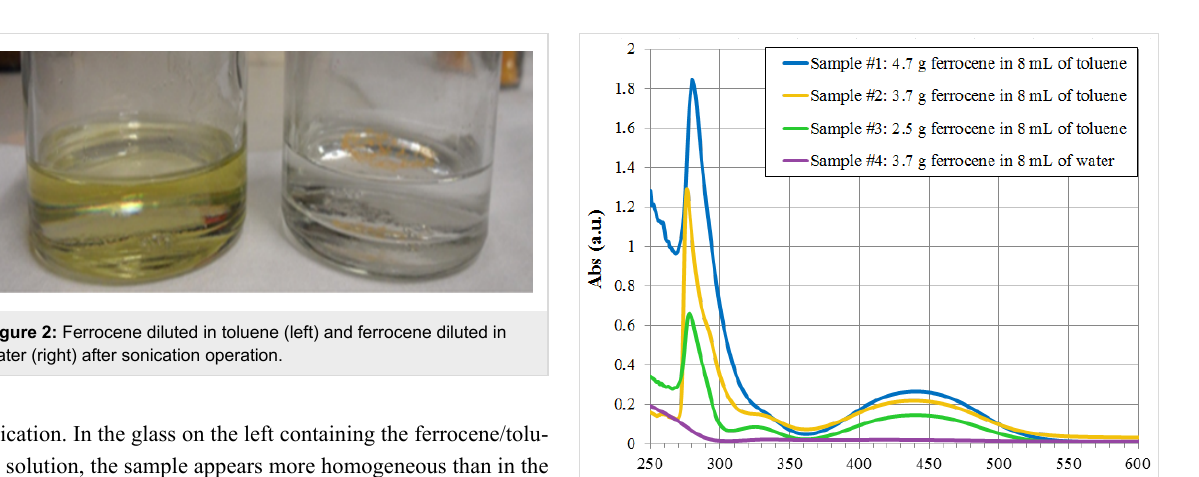
sonication. In the glass on the left containing the ferrocene/tolu- ene solution, the sample appears more homogeneous than in the glass on the right containing the ferrocene/water solution.